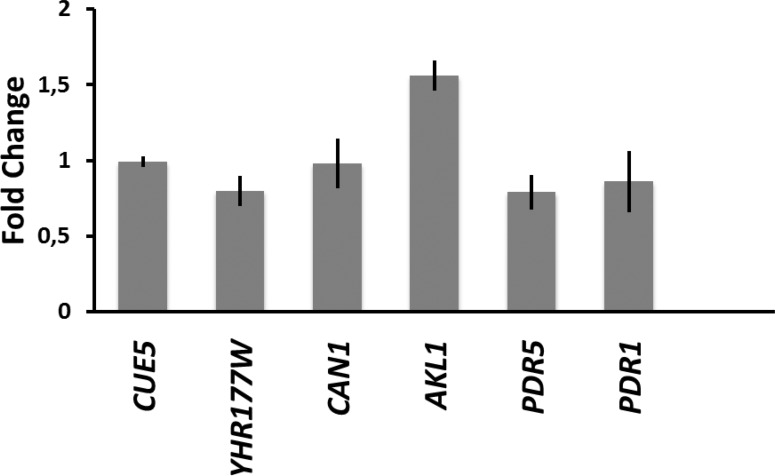
Real-Time PCR analyses of the genes that cause resistance to doxorubicin.The expression levels for genes were normalized by their untreated counterparts. Each sample was assayed at least 3 times and error bars show the SD of the means. ACT1 gene was used as the internal control.